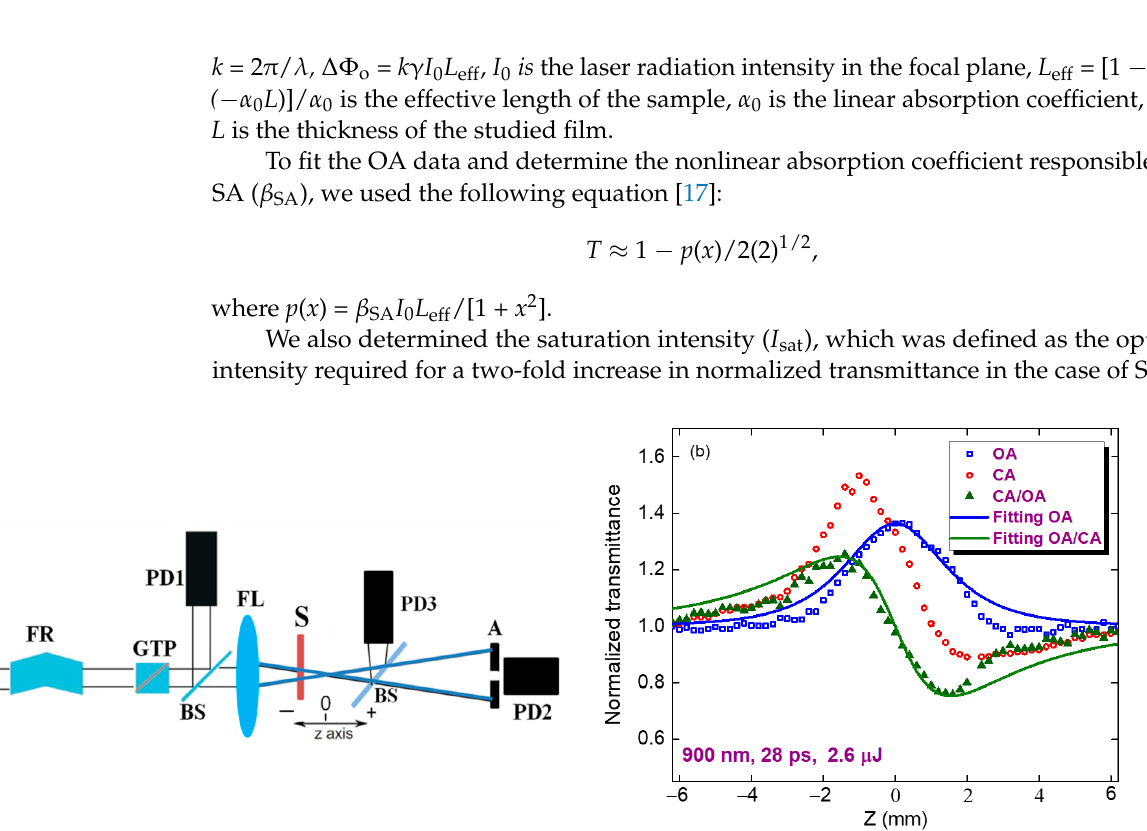
Figure 2. ( a ) Experimental setup for the nonlinear optical studies using the Z-scan scheme. PB: probing beam; FR: Fresnel rhomb; GTP: Glan-Taylor prism; BS: beamsplitter; FL: focusing lens; S: sample; A: aperture; PD1-PD3: photodiodes for determination of normalized transmittance, nonlinear refraction, and nonlinear absorption. ( b ) Z-scans of MTQD film using 900 nm, 28 ps pulses: closed-aperture scan (CA, red empty circles), open-aperture scan (OA, blue empty squares), and CA/OA division (green filled triangles). Solid curves represent the fittings using Equations (1) (green curve) and (2) (blue curve).